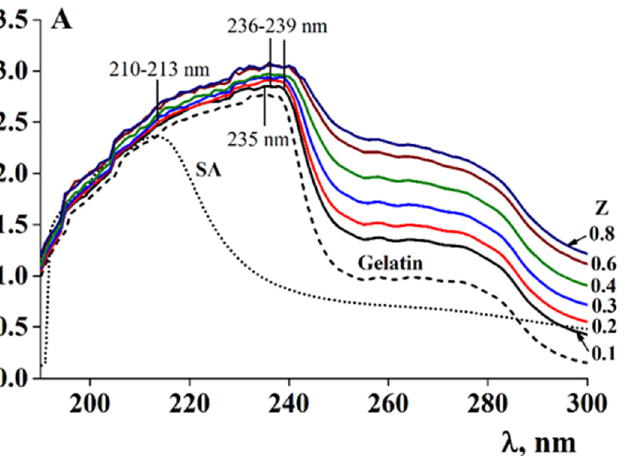
Figure 12. UV absorption spectra for sodium alginate (C SA = 0.5 wt.%), gelatin (C G = 1.0 wt.%) and aqueous mixtures of SA-gelatin mixtures with varying mass ratios Z.